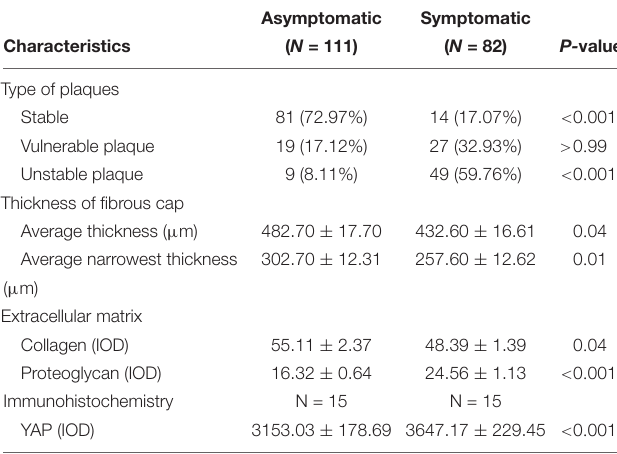
TABLE 5 | Pathologic characteristic of 193 plaques (111 asymptomatic, 82 symptomatic) and immunohistochemistry for 30 patients (15 asymptomatic, 15